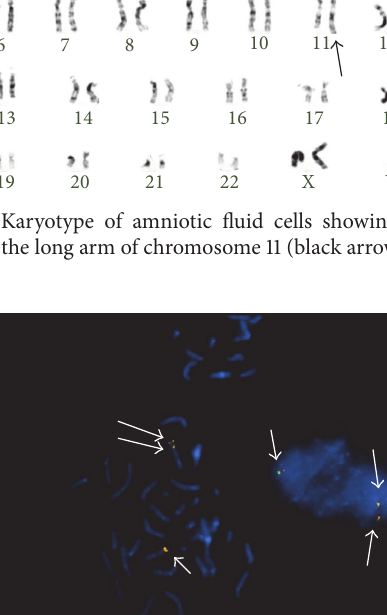
Figure 3: FISH analysis with MLL probes. Partial metaphase with MLL probes showed two signals in the 11q chromosome. Interphase nuclei showed three signals for MLL probes. White arrows show MLL hybridization